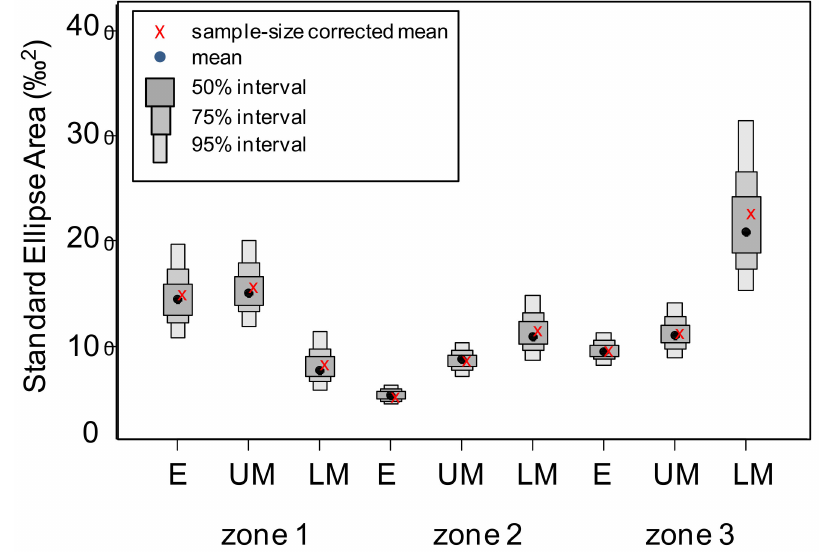
Figure 6. The standard ellipse areas for the food webs observed in the epipelagic (E), upper mesopelagic (UM), and lower mesopelagic (LM) layers of the zones marked in Figure 1 computed from the Bayesian multivariate normal distributions fitted to the original isotope data. The uncorrected (black dots) and sample–size corrected mode values (red crosses), along with the intervals encompassing 50%, 75%, and 95% of the estimations (shaded boxes) are indicated.